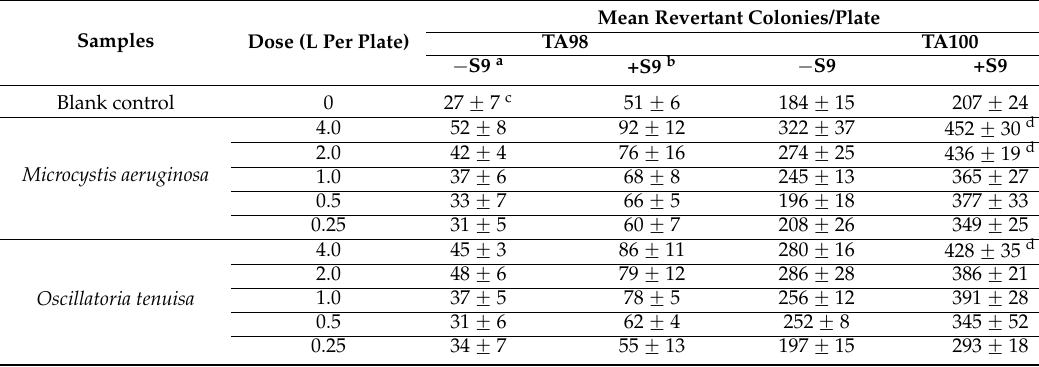
Table 2. Mutagenic activity of cyanobacterial EPS extracts in TA98 and TA100 Salmonella strains.